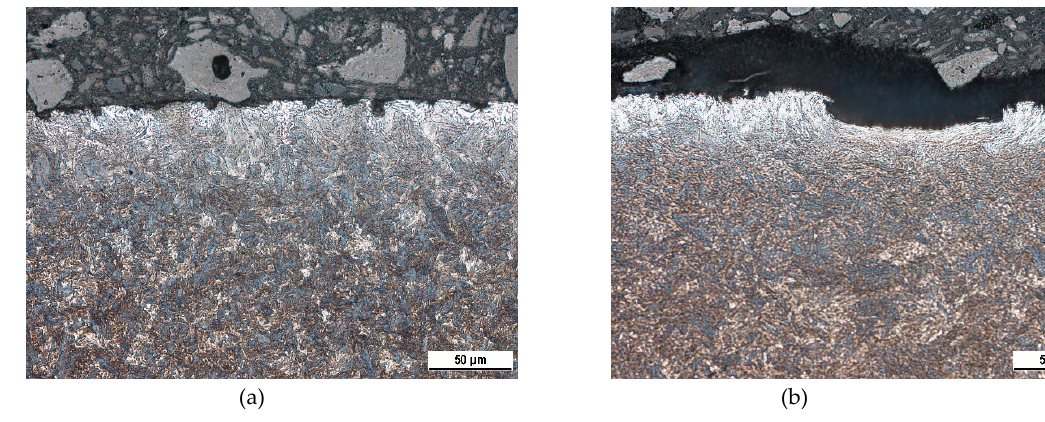
Figure 3. Metallographic images of wire n.2’s cross-sectional view. ( a ) Region 1; ( b ) region 2.